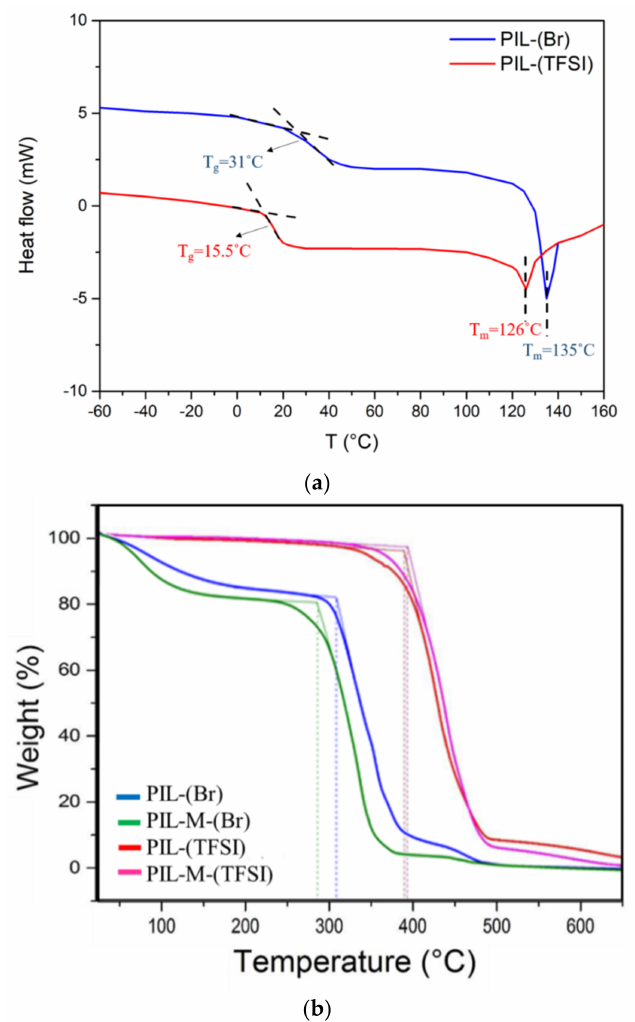
Figure 3. ( a ) Differential scanning calorimetric analysis of PIL-(TFSI) and PIL-(Br); ( b ) Thermal gravity analysis of PIL-(Br), PIL-M-(Br), PIL-(TFSI), and